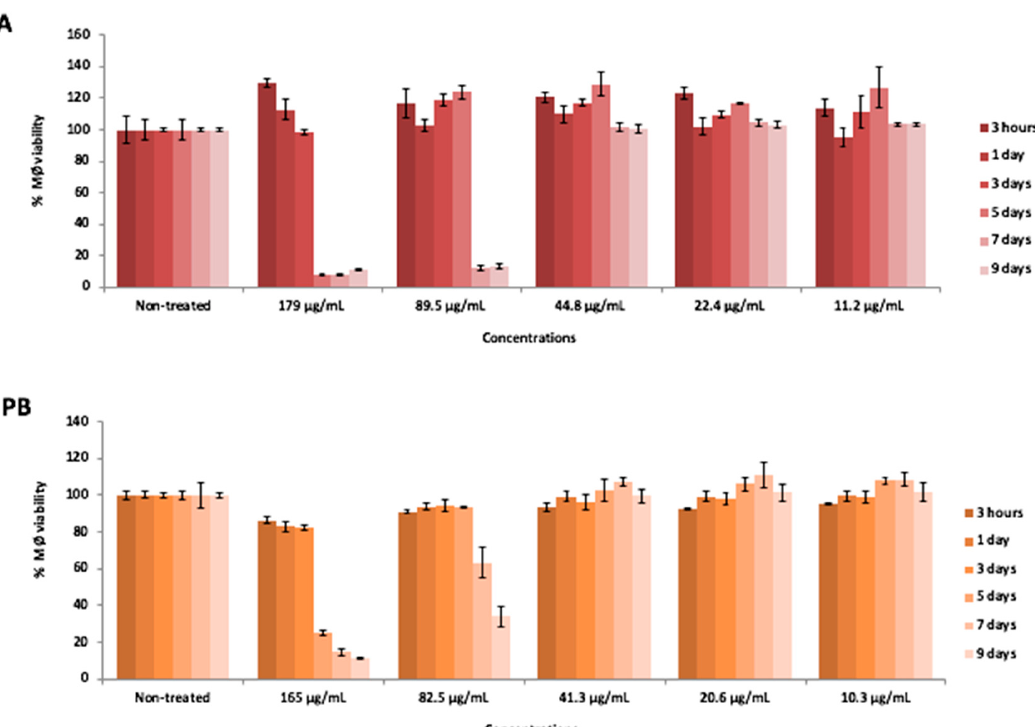
Figure 8. Macrophages viability, expressed as percentage respect to the control, after different times of incubation (3 h or 1, 3, 5, 7 and 9 days) with five distinct solutions prepared from SD Powder A (PA) and SD Powder B (PB) at different